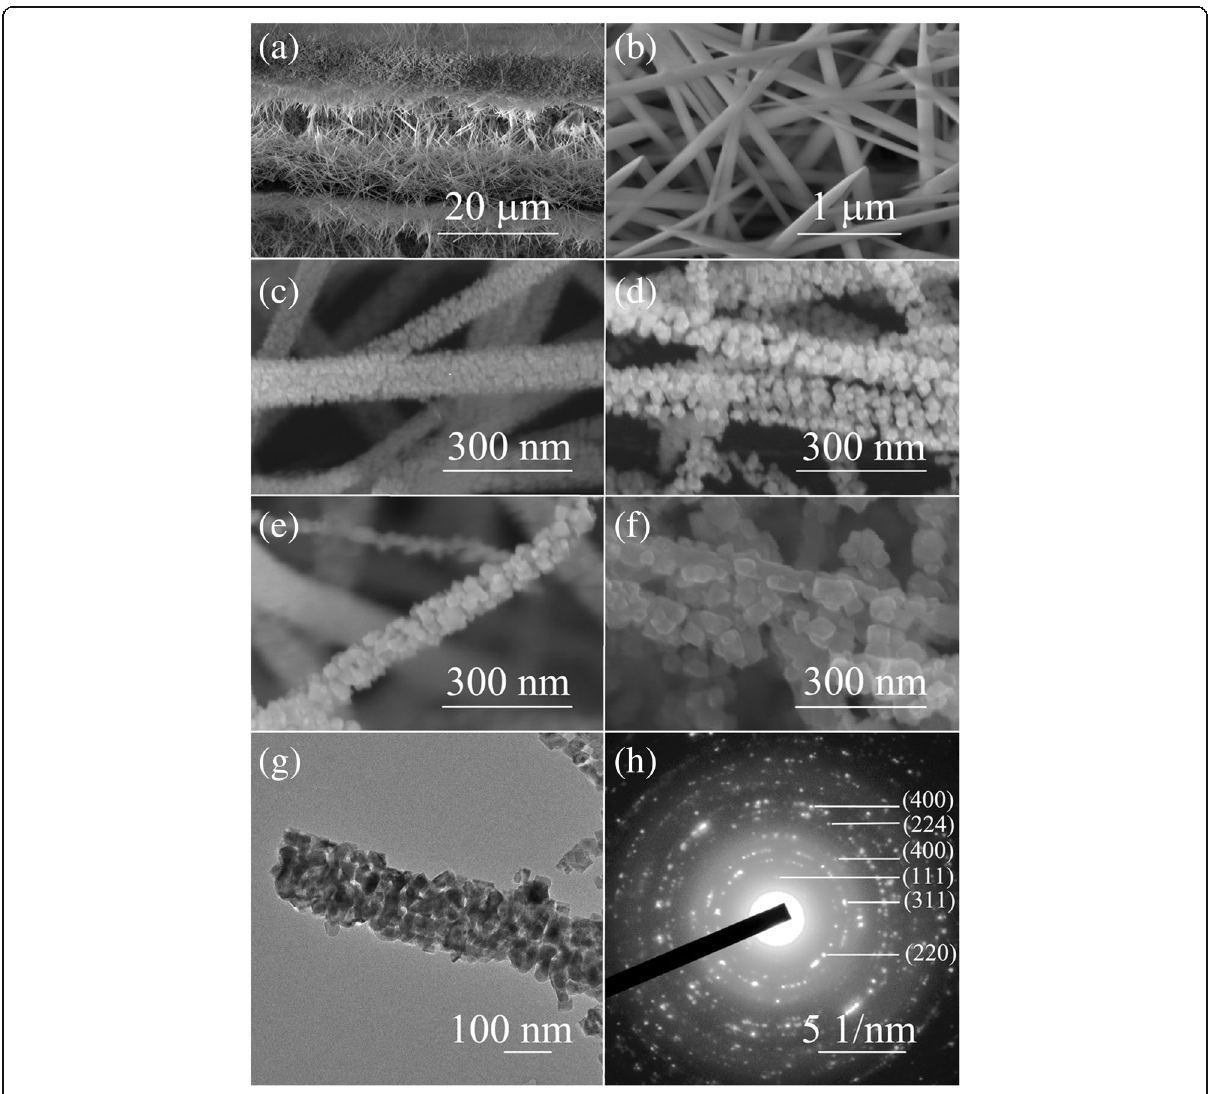
Fig. 1 a , b The SEM image and enlarged one of precursor NiCo 2 (OH) 6 nanowires. c – f The high-resolution SEM images of NiCo 2 O 4 nanowires at annealing temperatures of 300 °C, 330 °C, 360 °C, and 380 °C. g , h The TEM image and selected-area electron diffraction